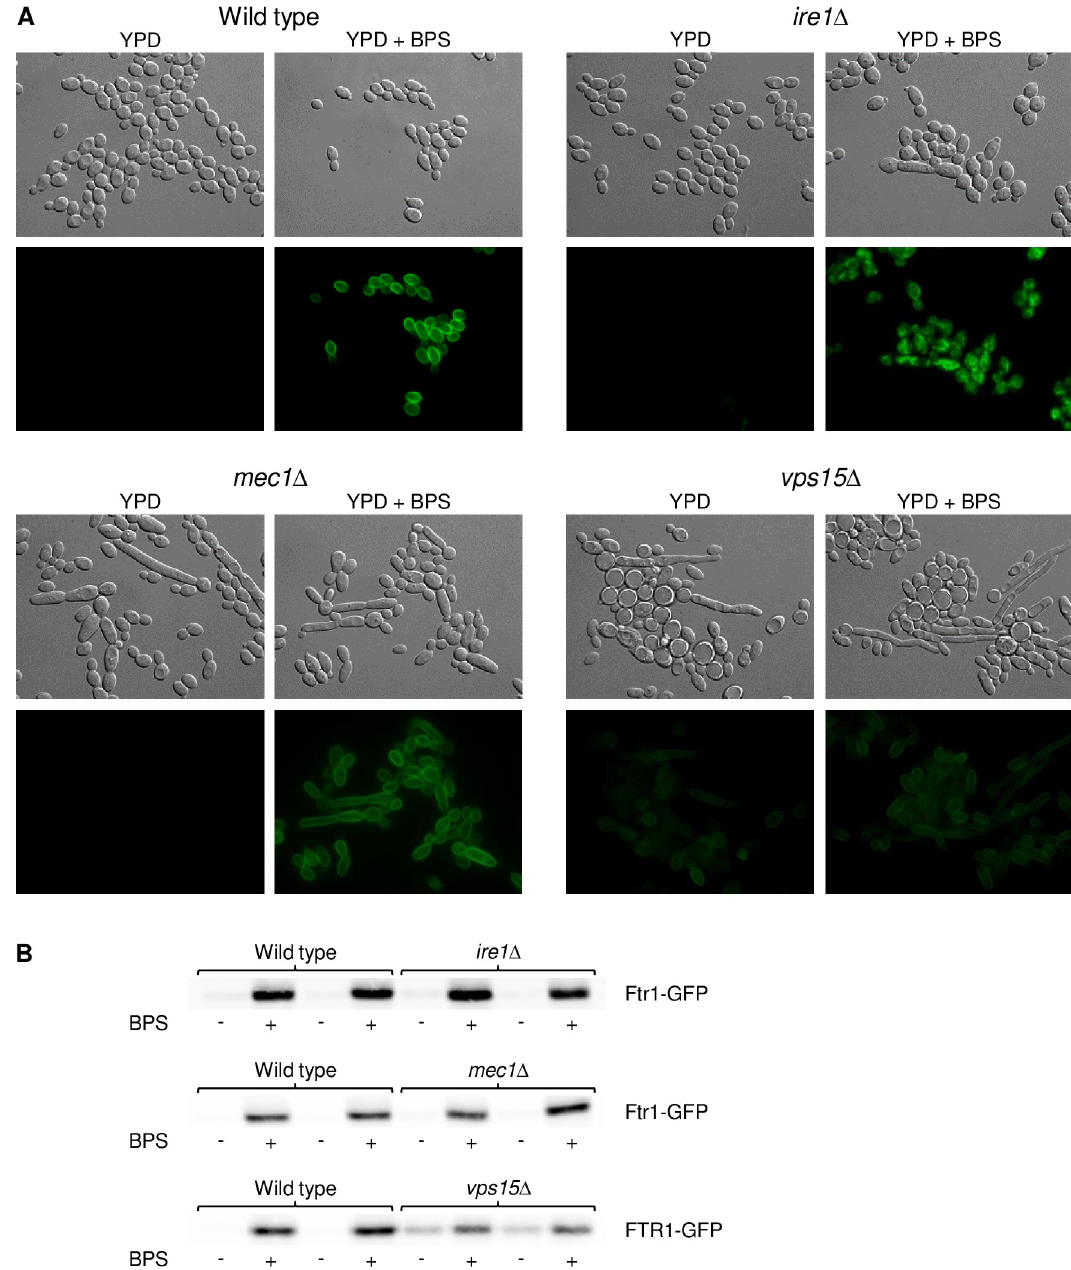
Fig 6. The high-affinity iron permease Ftr1 is mislocalized in ire1 Δ mutants. (A) Overnight cultures of the wild-type strain SC5314 and ire1 Δ , mec1 Δ , and vps15 Δ mutants carrying a GFP -tagged FTR1 allele were inoculated in fresh YPD medium without or with BPS and grown for 5 h at 30˚C. Cells were imaged by DIC and fluorescence microscopy. The two independently generated series of strains behaved identically and only one of them is shown. (B) Strains were grown as described above and analyzed by Western blotting with an anti-GFP antibody. Results for both independently generated series of strains are shown in each case.